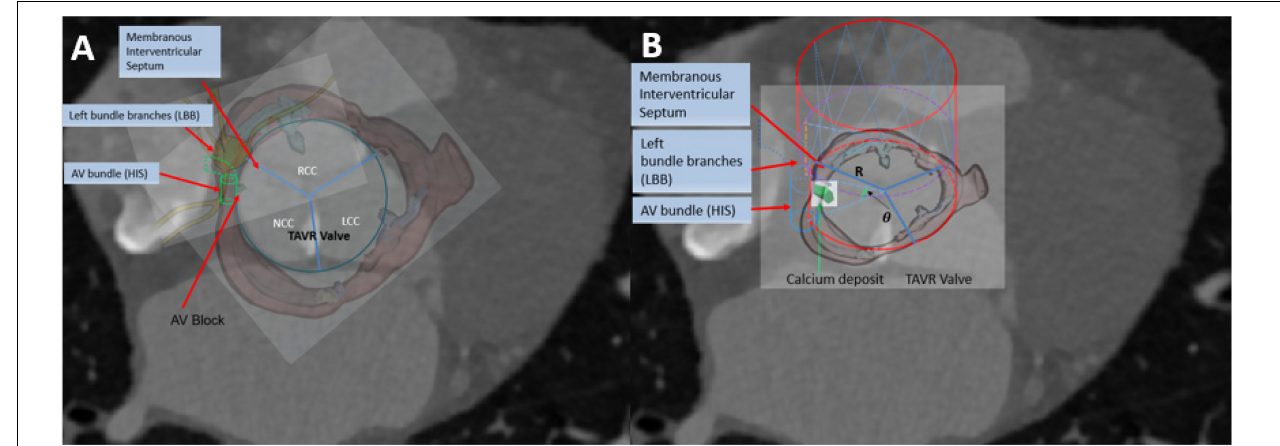
FIGURE 3 | Aortic Tissue with TAVR. (A) AVB with TAVR; (B) Optimal